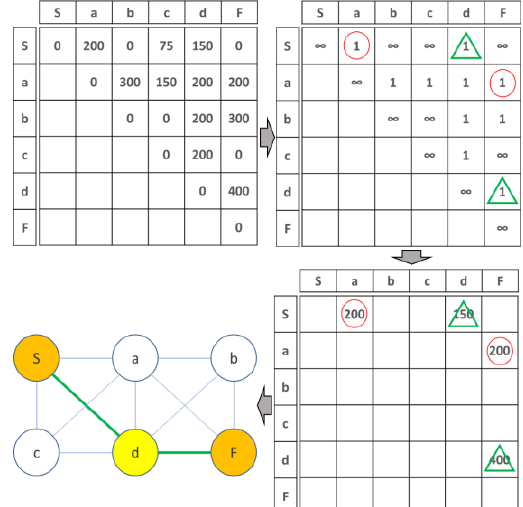
Figure 8. The distribution of DN values for all tie points (black crosses) and accepted tie points (red crosses)